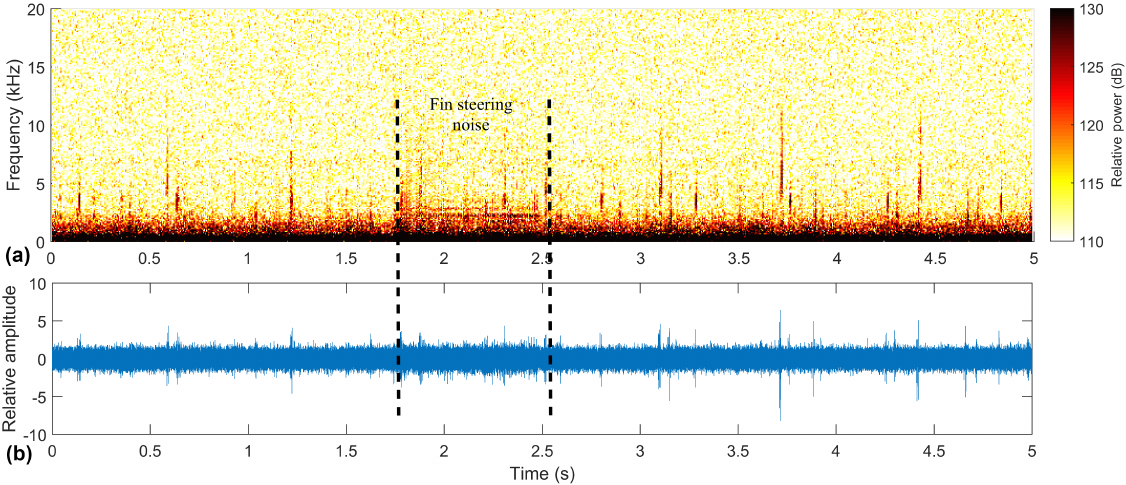
Figure 9. Spectrogram (a) and time series (b) of 5s of data showing an example of noise (between dashed lines) produced by fin steering in the glider, with sperm whale echolocation clicks (narrow vertical bars) around it.